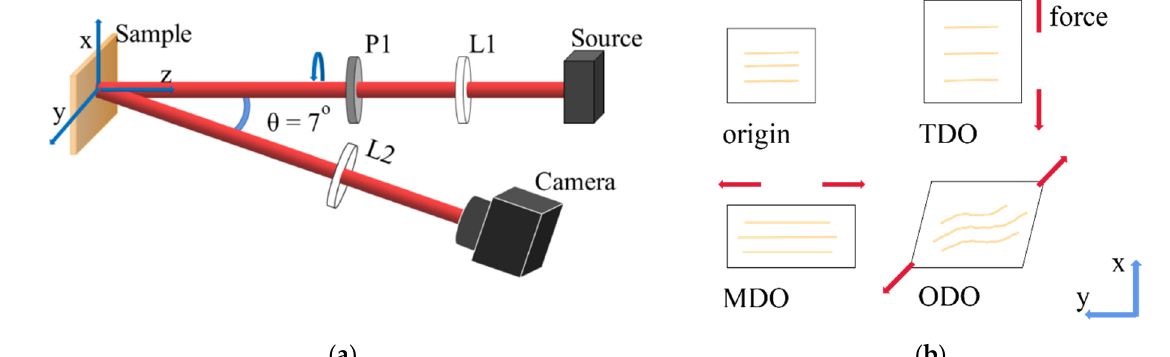
Figure 1. ( a ) Schematic of the experimental setup for the backscattering Mueller matrix measurement. P1: polarizer; L1, L2: lens. The oblique incident angle θ is about 7 deg to avoid the surface reflection from the sample. The diameter of the illumination area is about 2.3 cm. ( b ) Schematic diagram of four stretching states of tendon tissue samples: origin means unstretched, TDO means transverse stretched, MDO means longitudinal stretched and ODO means 45 deg stretched. The light orange lines represent the fibers.